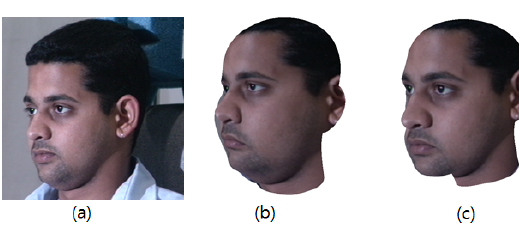
Figure 6. 3D reconstruction results with and without the proposed fitting method: ( a ) Input image. ( b ) 3D face without proposed method. ( c ) 3D face with proposed method.